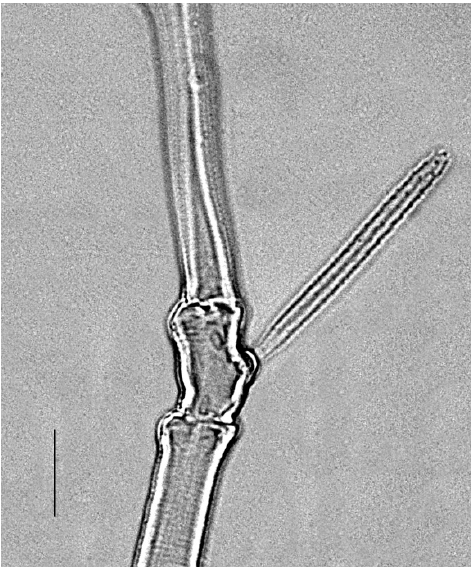
Figure 24. Neophyllobius muscantribii . Female. Genu III. Scale bar: 50 μ m.